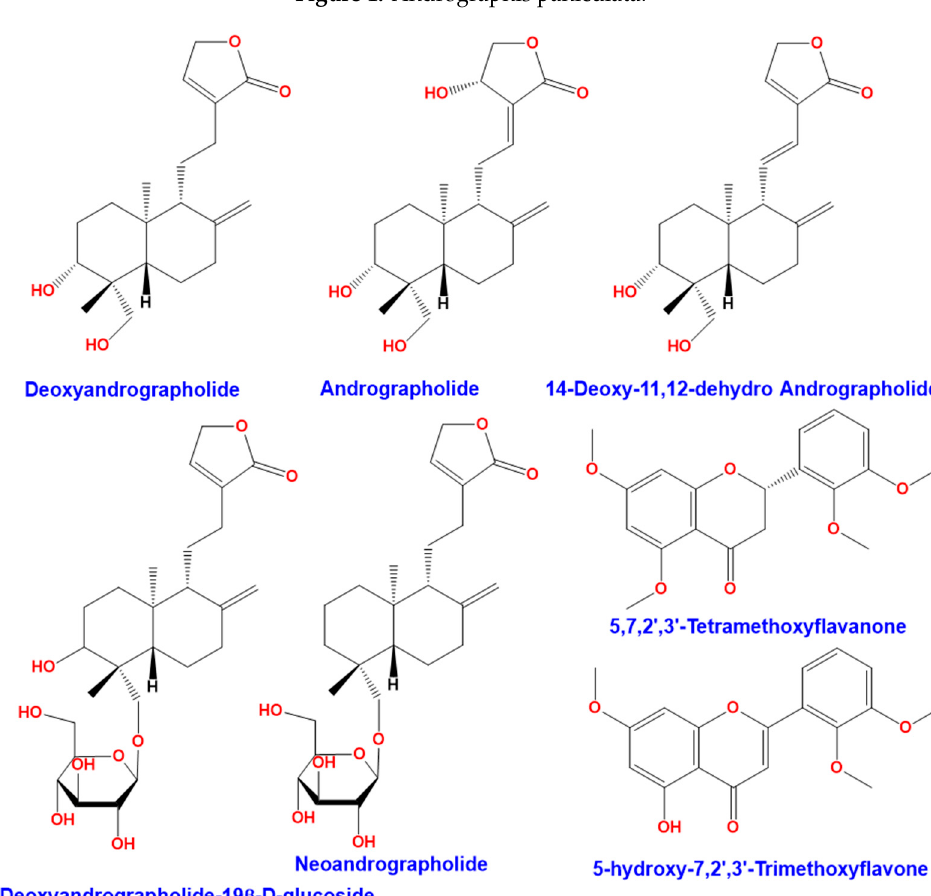
Figure 2. Compounds found in the leaves of Andrographis paniculata.